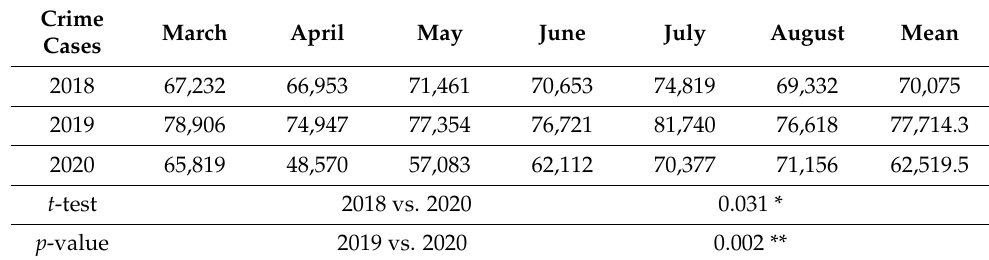
Table 1. Paired t -test of COVID-19 infection rate and crime rate for three months.